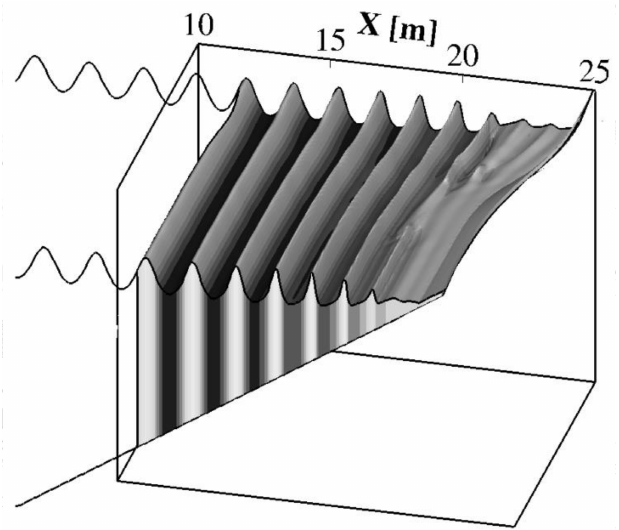
Figure 7. Case 1: Three-dimensional view detail of an instantaneous wave field at the time when the breaking induced circulation is fully developed.